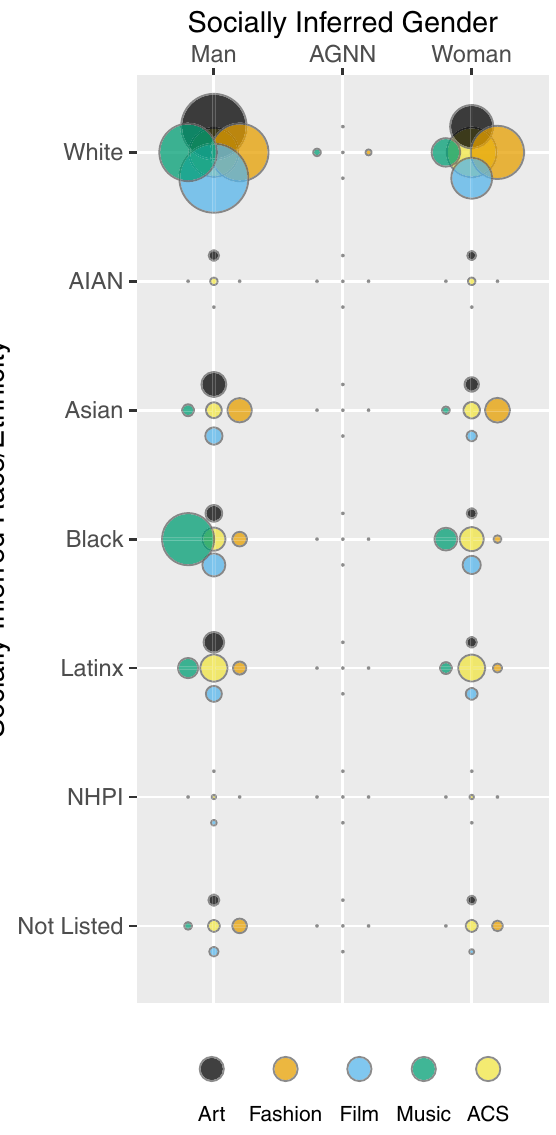
Fig. 4 Socially inferred intersecting gender and ethnicity data compared across domains and to American Community Survey (ACS) data (U.S. Census Bureau, 2019). At each categorical intersection point, the black bubble represents the share of that identity group within the U.S. population, and the colored bubbles represent the shares within each creative domain. See Table 1 for numerical data. Note: AGNN agender, gender nonconforming, or nonbinary, AIAN American Indian/Alaska Native, NHPI Native Hawaiian/Paci fi c Islander, Not Listed an identity not captured by the other